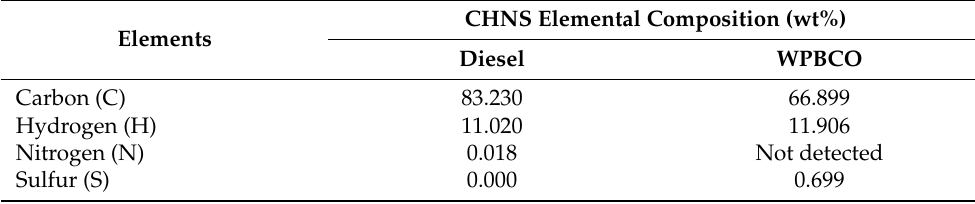
Table 6. CHNS elemental analysis of diesel fuel and